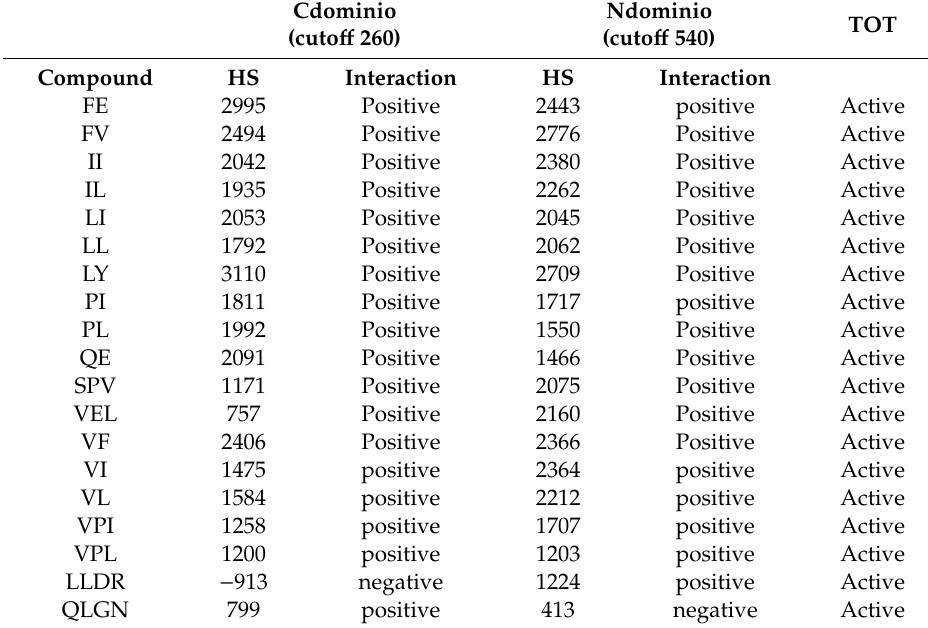
Table 3. Computational in silico results obtained for the analyzed peptides sequences, presented as HINT (Hydrophatic INTeraction) scores and expected activity of peptides under